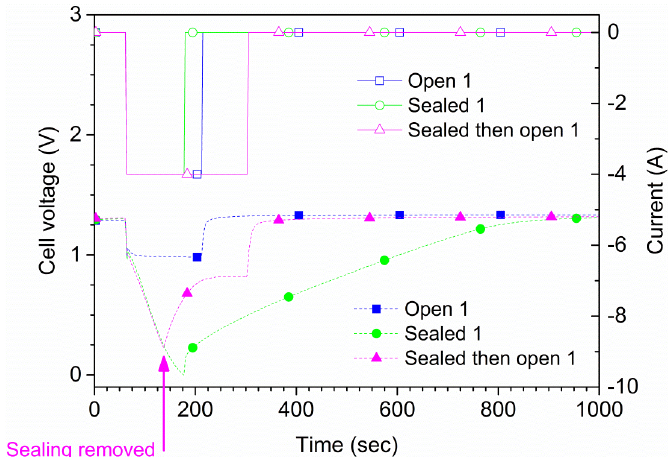
Figure 4. Voltage (filled symbols) and current (open symbols) measurements for cell 1 for three different tests using a discharge current of 4 A; in open air; sealed (suffocated) for 150 s or until the cell potential reached 0 V; and first sealed (suffocated) then open in air.